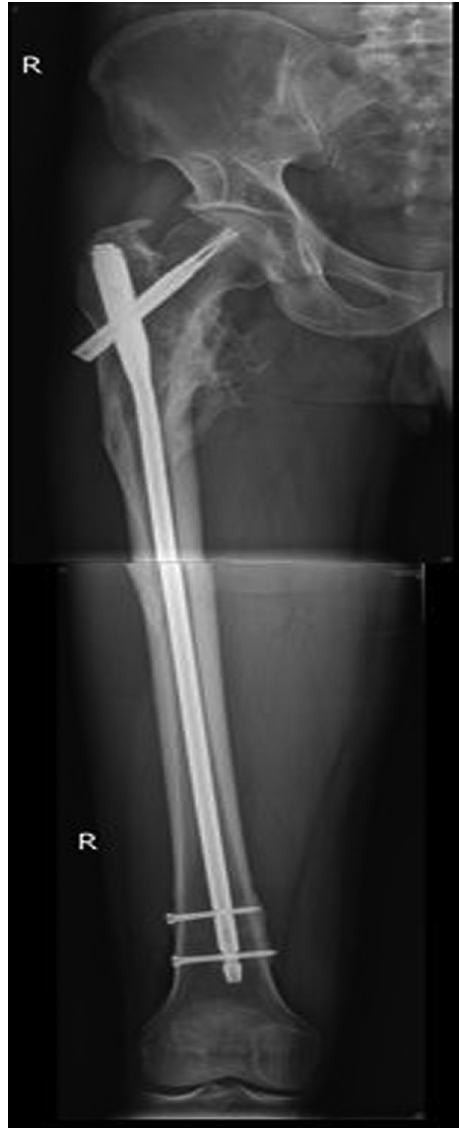
Figure 5: Patient with femoral intertrochanteric fracture accepted intramedullary nailing and the fracture eventually healed.